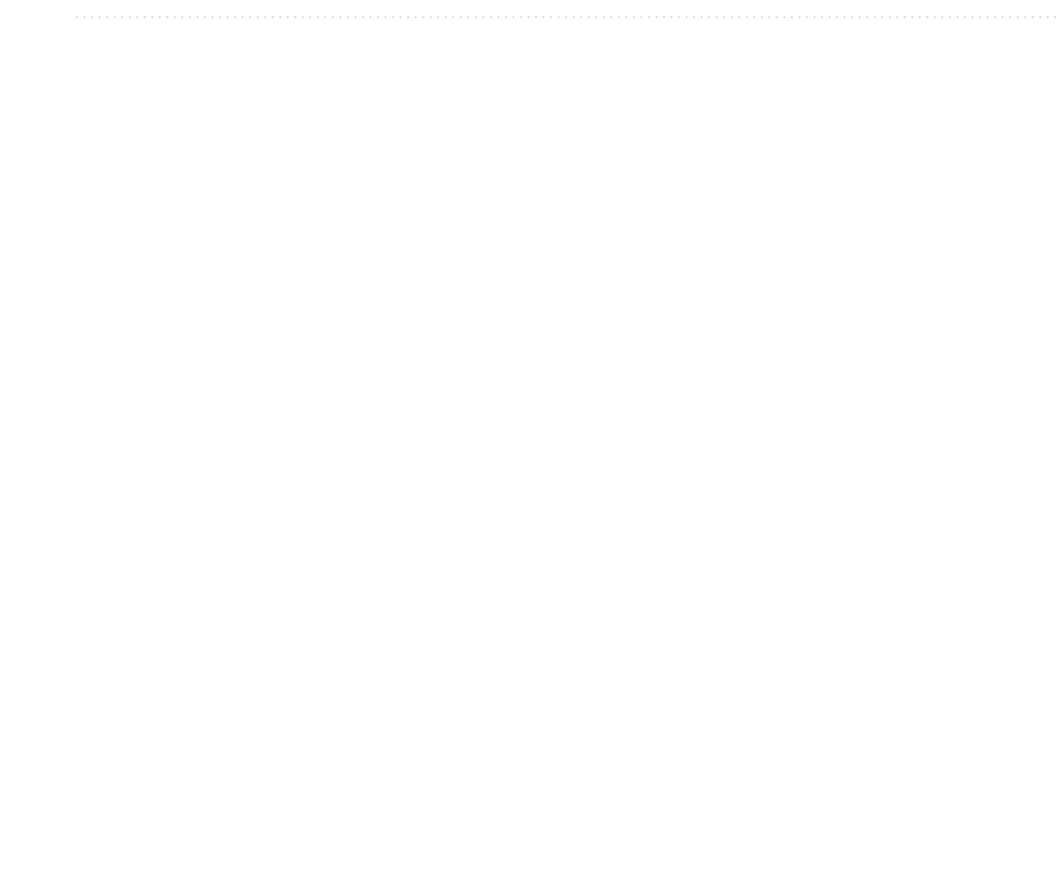
Table 9. Hyperparameters used in the machine learning